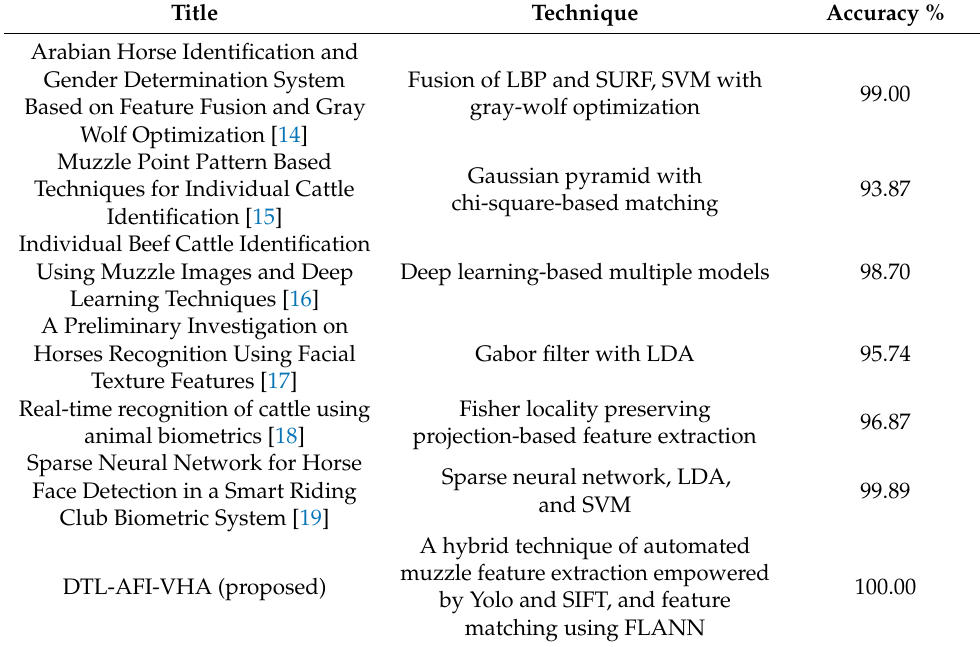
Table 4. Comparison of the proposed system with other